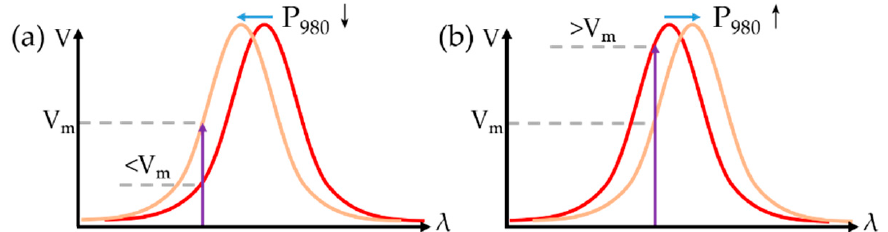
Figure 6. Operating principle and process of maintaining a stable operating point: ( a ) a recorded mean below V m prompts a reduction in the heating laser power, and ( b ) a recorded mean larger than V m prompts an increase. (The red line represents the original voltage signal with initial heating power; the orange line represents the changed voltage signal with changed heating power.)